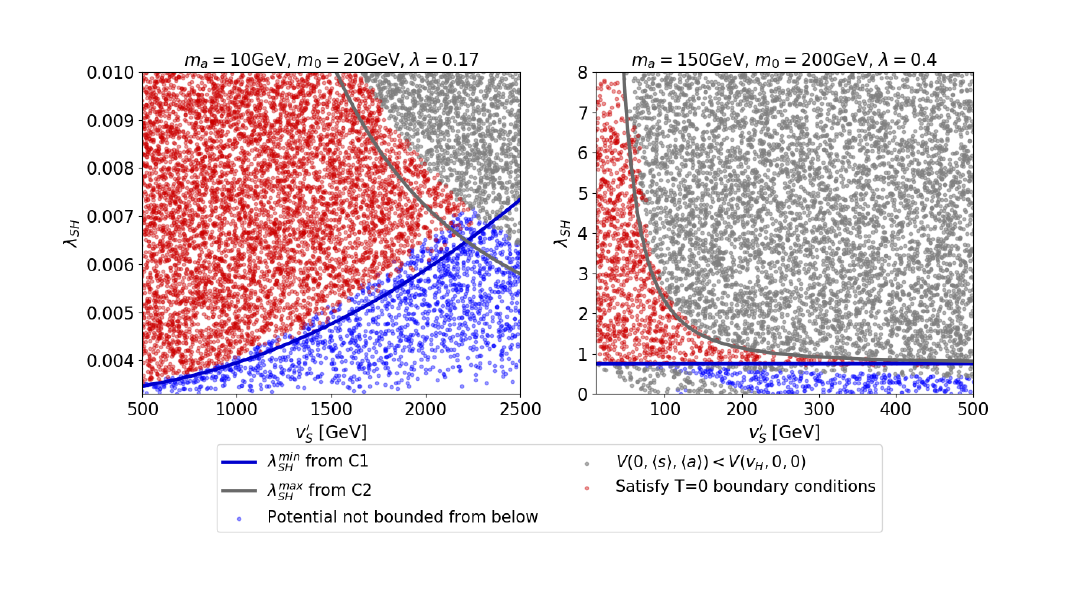
Figure 3. Results of the zero temperature numerical scans at one loop level on the v 0 − λ SH plane S with fixed parameters (a) m = 10 GeV, m = 20 GeV , λ = 0 . 17 and (b) m = 150 GeV, m = a 0 a 0 200 GeV , λ = 0 . 4 . The benchmarks satisfying zero temperature boundary conditions are shown in red, benchmarks not satisfying BFB are shown in blue and benchmarks where the EW vacuum is not the global minimum are shown in gray. Analytical conditions C1 (loop-level, BFB) and C2 (tree- level, global minimum) are shown by the blue and gray lines. The gray points below the blue line, which should also be colored blue, in the right plot have a global minimum different from the EW minimum, despite satisfying C2 , due to the significant one loop effects to the small quartic